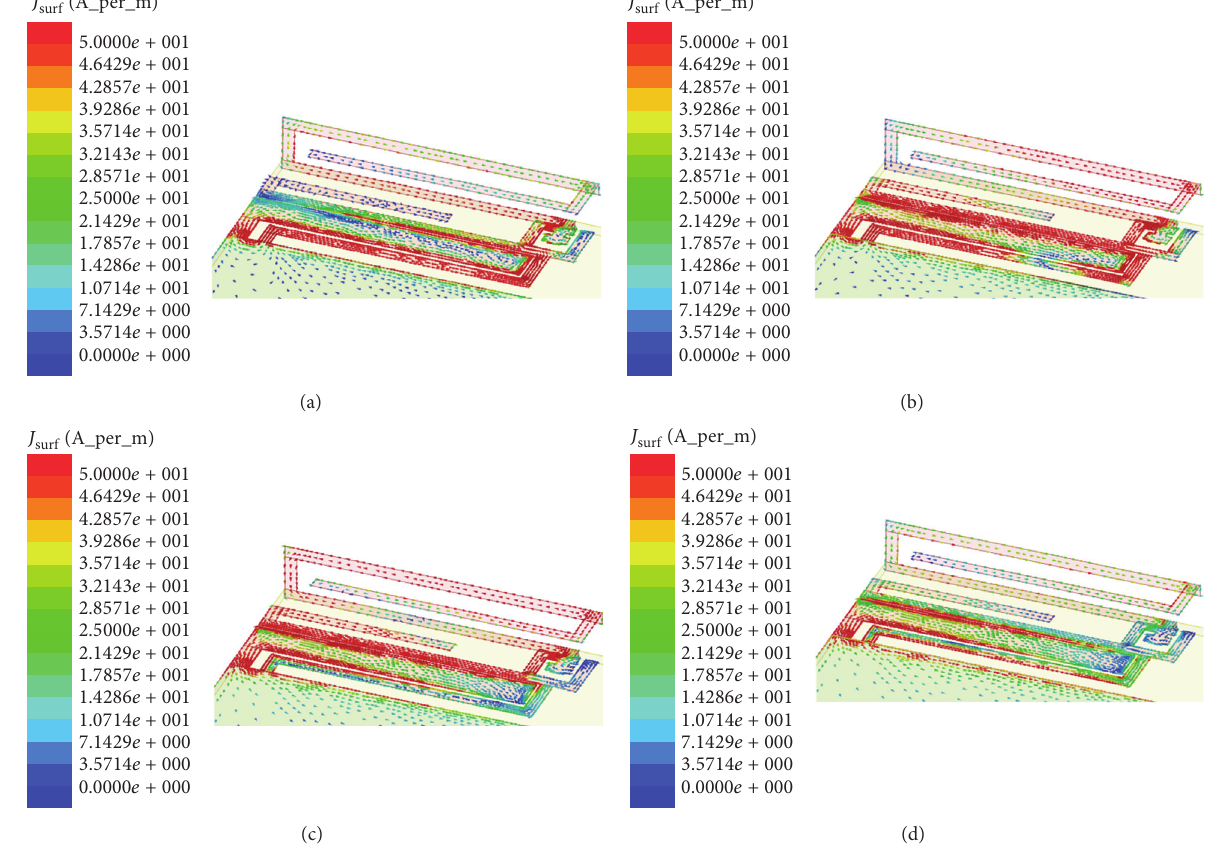
Figure 6: Simulated surface current distributions of antenna 1 at (a) 900 MHz, (b) 1780 MHz, (c) 2040 MHz, and (d) 2640 MHz.